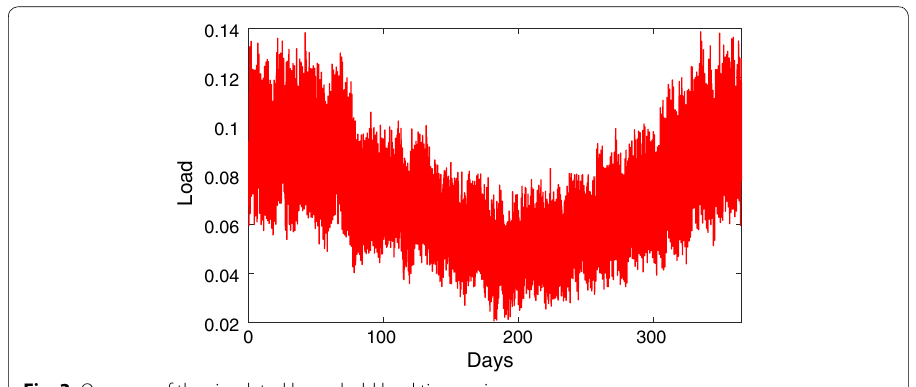
Fig. 3 One year of the simulated household load time